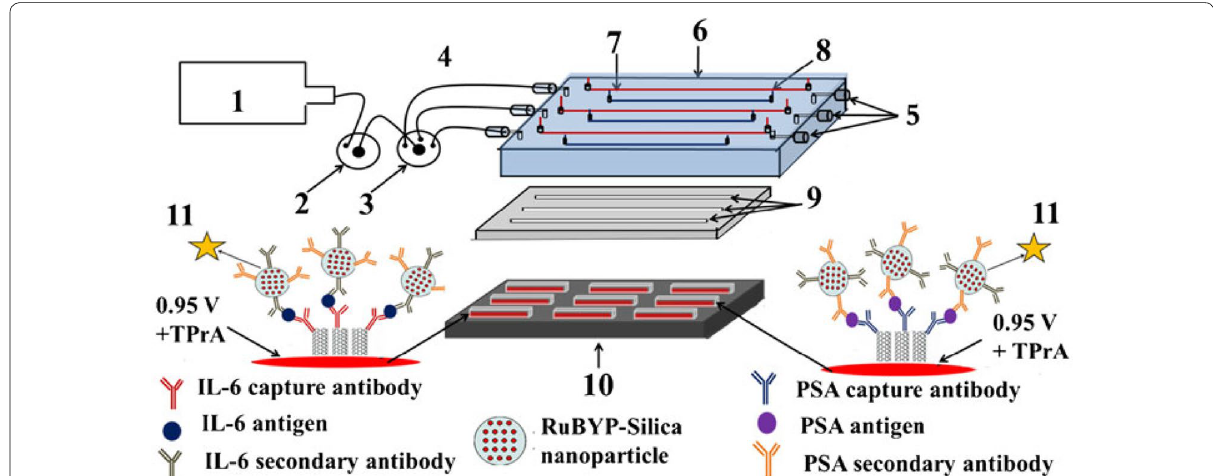
Fig. 7 Design of microfluidic ECL array for cancer biomarker detection. ( 1 ) syringe pump, ( 2 ) injector valve, ( 3 ) switch valve to guide the sample to the desired channel, ( 4 ) tubing for inlet, ( 5 ) outlet, ( 6 ) poly(methylmethacrylate) plate, ( 7 ) Pt counter wire, ( 8 ) Ag/AgCl reference wire, ( 9 ) polydi- methylsiloxane channels, ( 10 ) pyrolytic graphite chip ( black ), surrounded by hydrophobic polymer ( white ) to make microwells. Bottoms of microw- ells ( red rectangles ) contain primary antibody-decorated SWCNT forests, ( 11 ) ECL label containing RuBPY-silica nanoparticles with cognate secondary antibodies are injected to the capture protein analytes previously bound to cognate primary antibodies. ECL is detected with a CCD camera (Figure reproduced with permission from: Ref. [80]. Copyright (2013) with permission from Springer